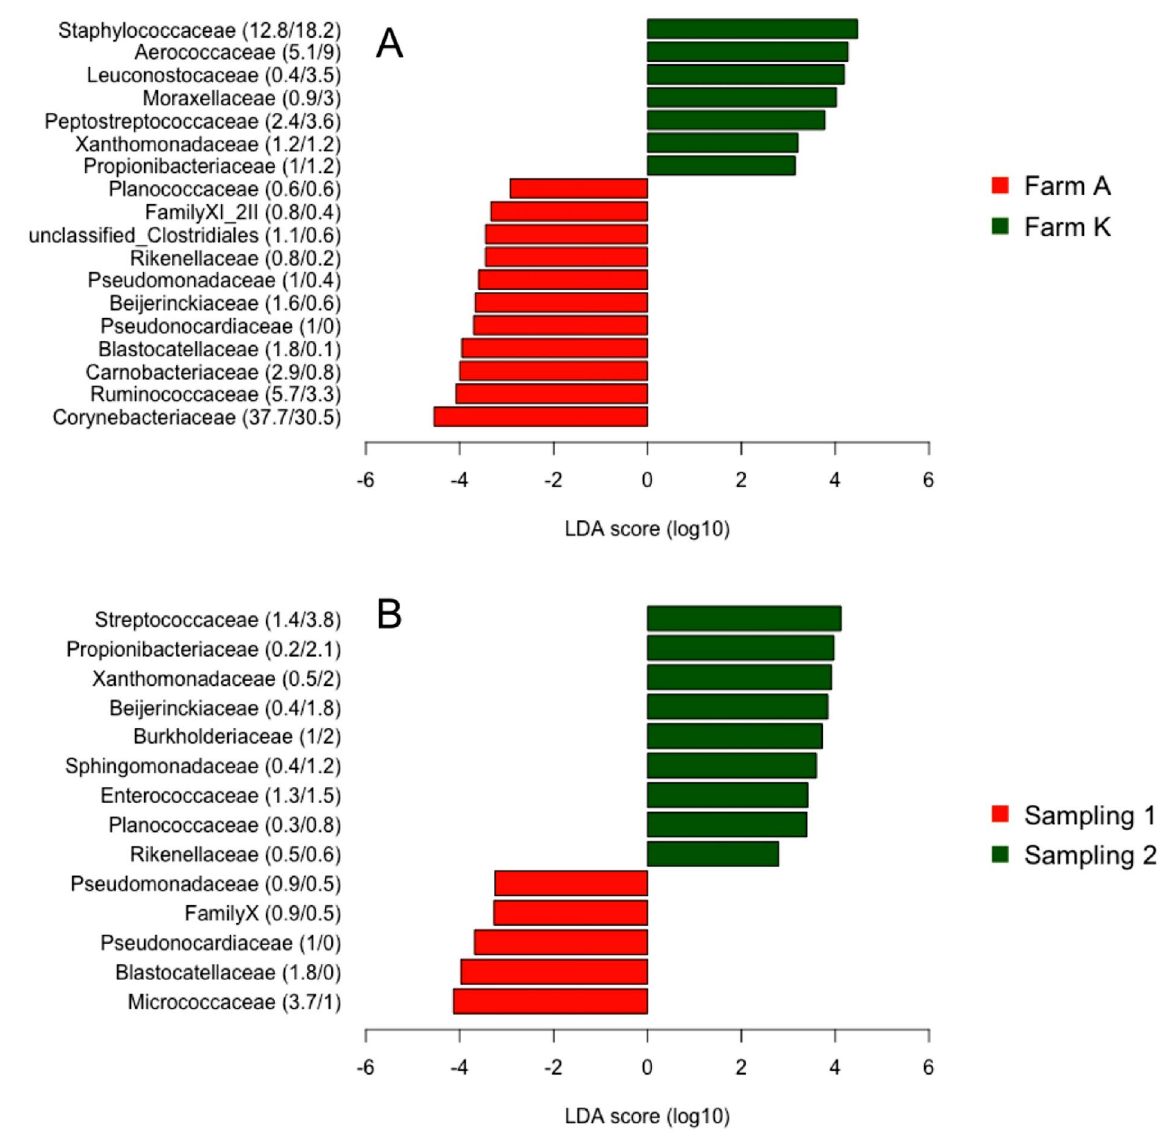
names are the percentage of abundance detected for each